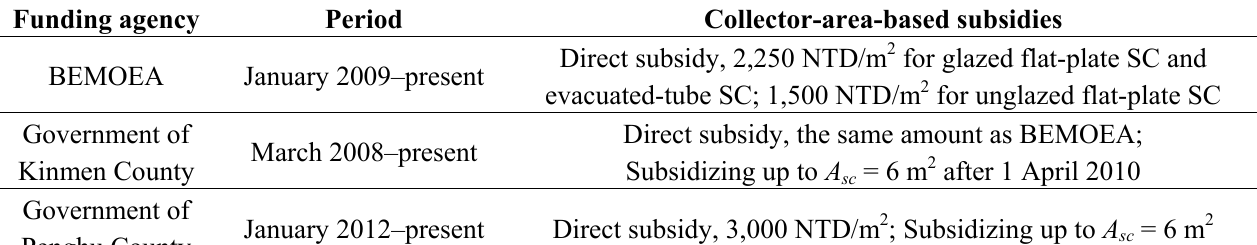
Table 1. Subsidy programs in